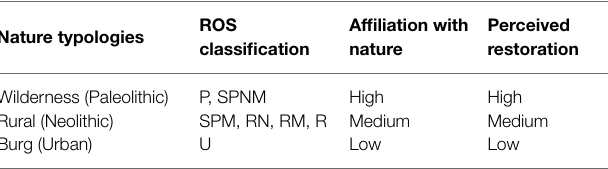
TABLE 1 | Individual’s preference for Nature typologies (the first two columns from the left) affects the individual’s perception of the benefits to obtain in terms of subjective wellbeing (the last column on the right), and this perception is mediated by the individual’s connection to Nature (the third column from the